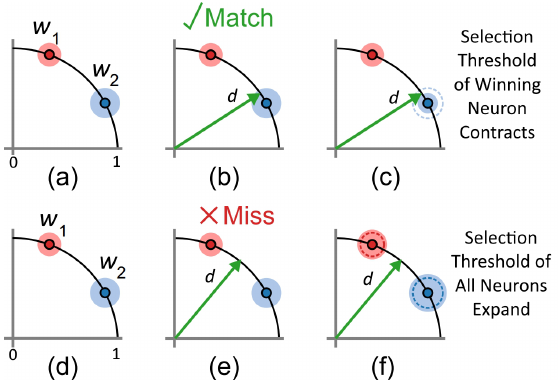
Figure 2. Diagram showing the adaptive threshold clustering in a 2D space. The diagram above shows a simplified case of the adaptive threshold clustering applied to features consisting of two dimensions. An existing configuration with two normalized features is shown in ( a ) and ( d ) on the unit circle, and with independently configured thresholds. If a following input ROI falls within the selective threshold distance of an existing feature, as shown in ( b ), then it is said to have matched and is assigned to the that feature. The threshold for that feature is then reduced as shown in ( c ). If the event does not match any existing features, as in ( e ), the input is discarded (missed event) and the thresholds for all features are increased as in ( f